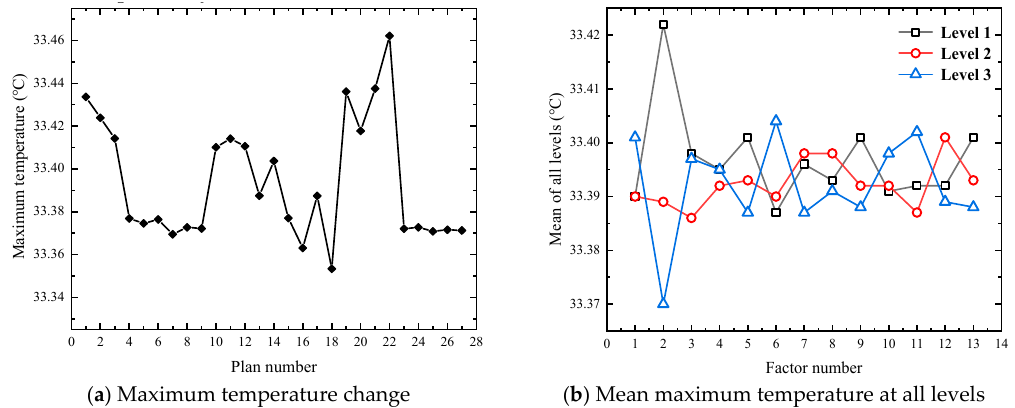
( b ) Mean maximum temperature at all levels Figure 4. Variation of simulation results of maximum temperature in an orthogonal experiment.